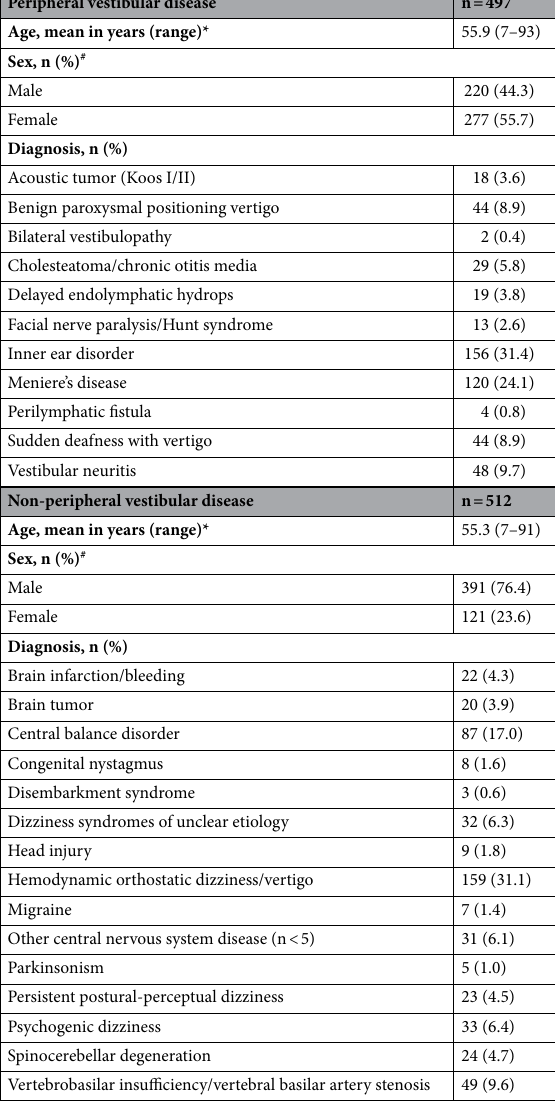
Table 1. Demographic data and clinical diagnosis of patients. *Mann–Whitney U test, P = 0.727. # Chi-squre test, P <